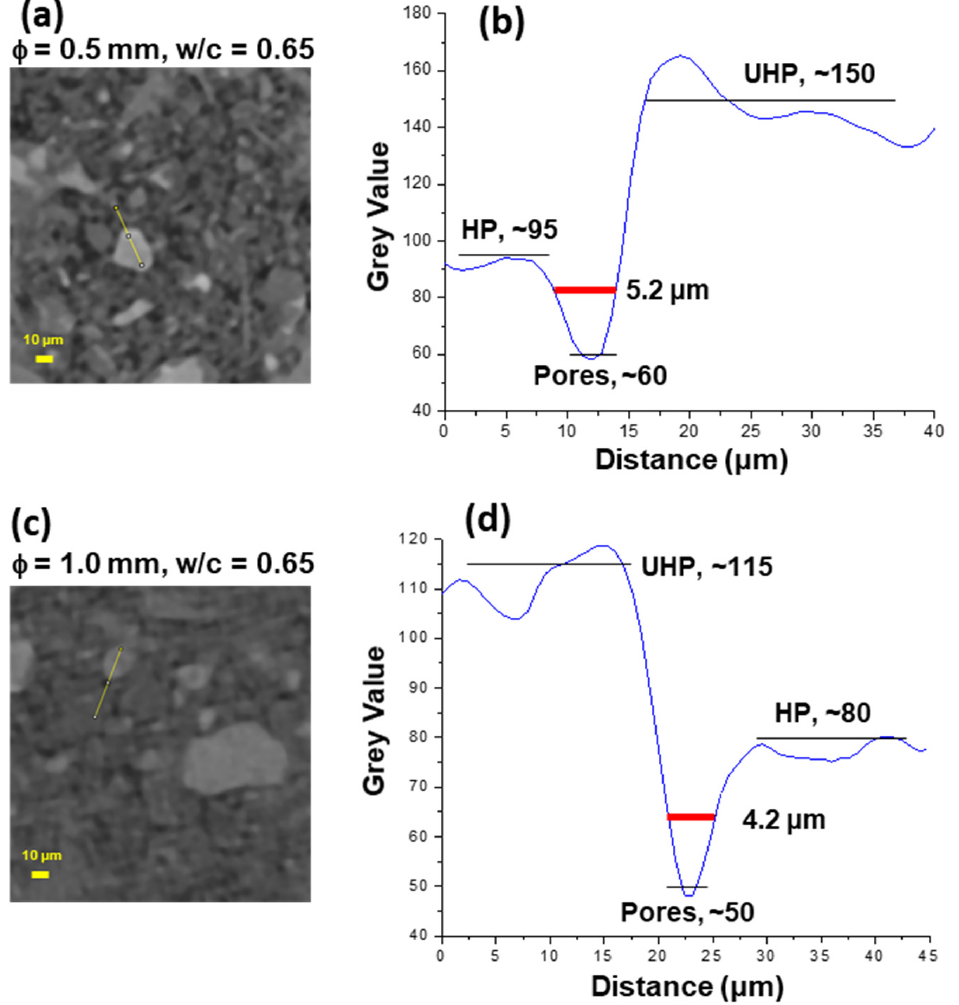
Figure 5. (Left) Selected enlarged views of two reconstructed slices. (Right) Plot profiles of the grey-scale values along the yellow lines depicted in the left panels which help to estimate the true spatial resolution. ( a ) The yellow line, from up to bottom, depicts hydrated products (HP), a pore and unhydrated cement products (UHP) with average grey-scale values given in ( b ). ( c ) The yellow line, from up to bottom, depicts: UHP, a pore and HP with average grey-scale values given in ( d ).